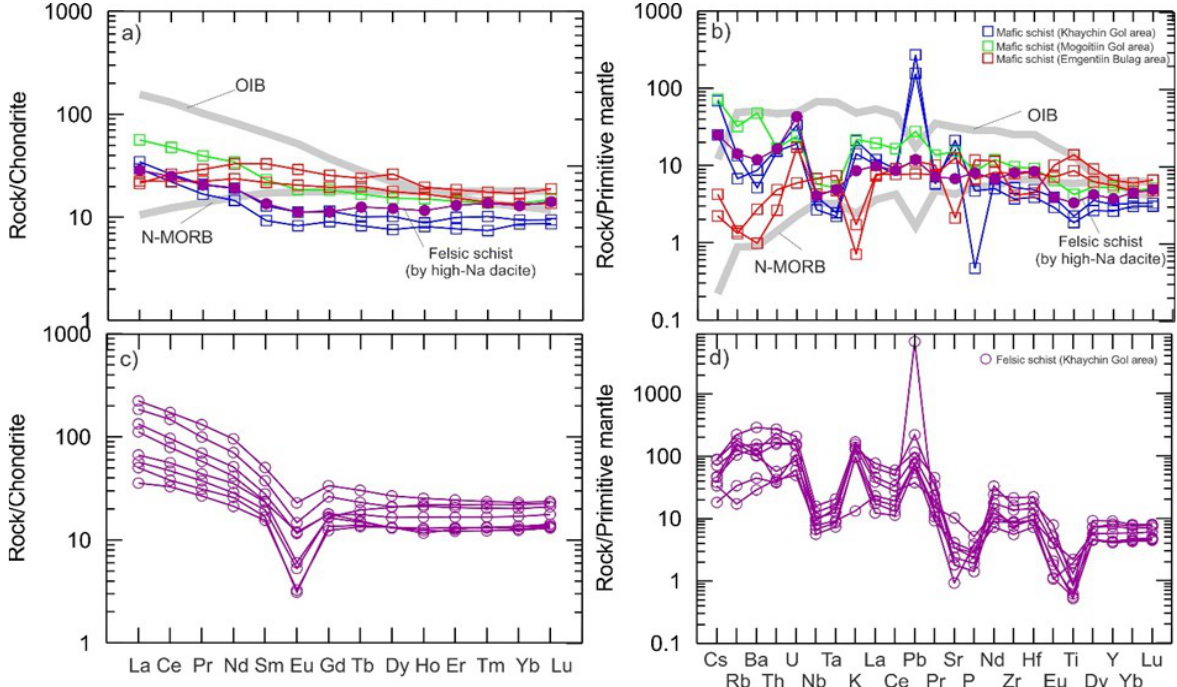
Fig. 9. Chrondrite-normalized REE patterns and primitive mantle-normalized trace element spider diagrams for studied mafic and felsic schists. Chondrite- and primitive mantle-normalization values are from Sun and McDonough (1989). OIB and N-MORB data from Sun and McDonough (1989) are plotted for comparison, respectively. OIB, Oceanic island basalt; N-MORB, Normal mid-ocean ridge